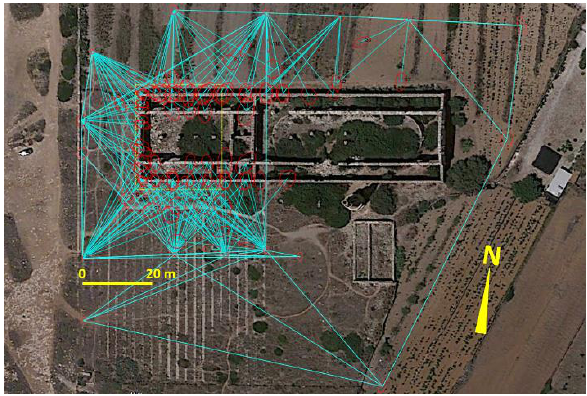
Figure 4. Furnace topographic surveying (ellipses scale 500x).